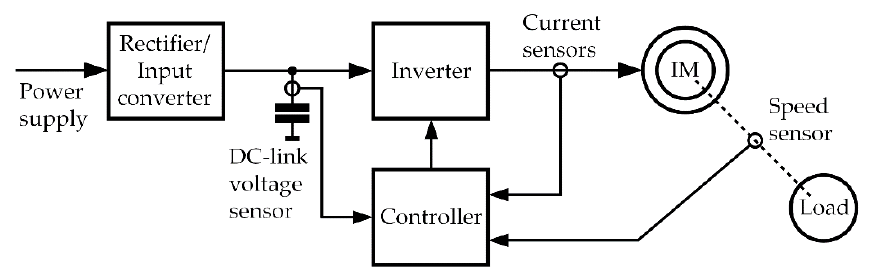
Figure 1. Structure of a common drive with induction machine.